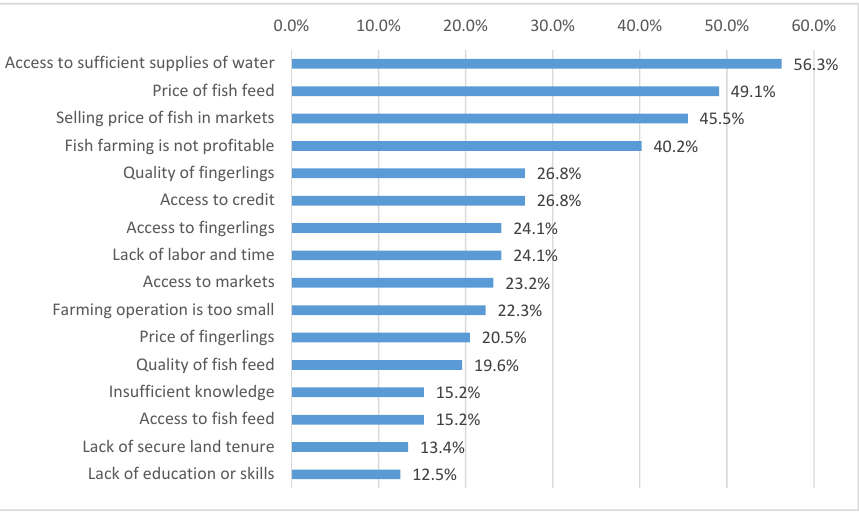
Figure 4. Comparisons of respondents’ agreement with statements regarding aquaculture ( n = 436). Statistical tests were conducted on responses to questions about statements about small-scale aquaculture between those respondents who indicated that they continue to farm fish and those who did not. The Mann-Whitney test is a non-parametric test of the differences in median values that makes no assumption about the distribution of responses between the two groups. A p -value (Prob > |z|) of 0.05 or less indicates that there is a significant difference between the responses of the two groups at a 5 percent significance level. Responses to these questions are presented in Table 8,